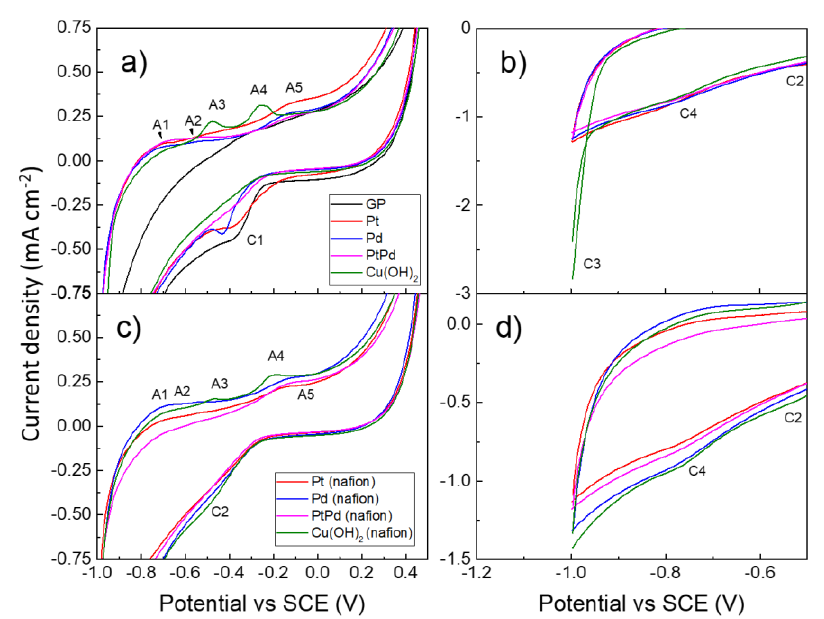
Figure 3. Cyclic voltammograms of GP alone (black line) Pt (red line), Pd (blue line), Pt 80 Pd 20 (magenta line), and Cu(OH 2 (olive line); ( a , b ) drop casting by water suspension; ( c , d ) drop casting by suspension in water 0.25% wt. Nafion. Conditions: KOH 1 M; scan rate 20 mVs − 1 .